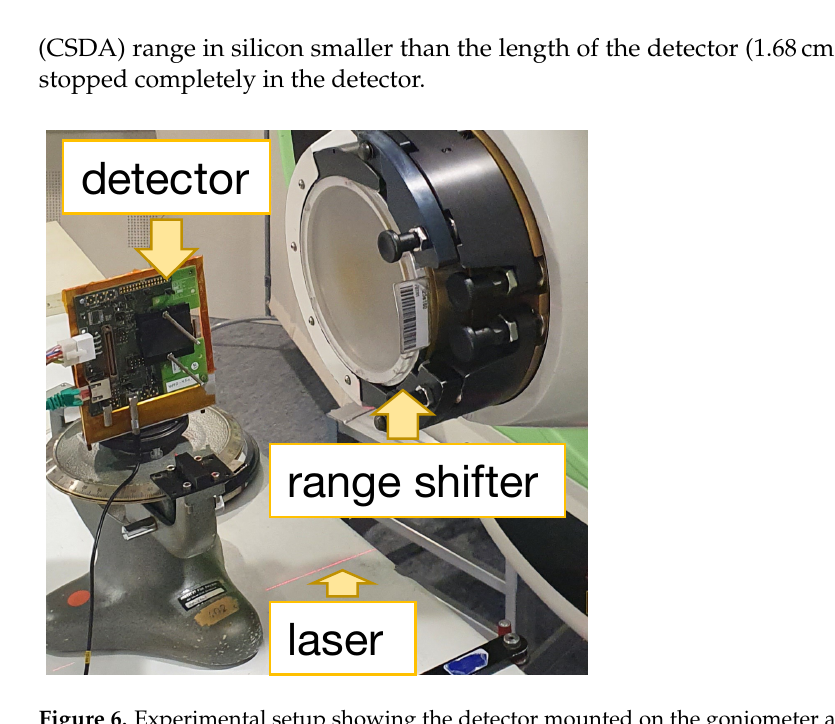
Figure 6. Experimental setup showing the detector mounted on the goniometer and aligned parallel with the beam